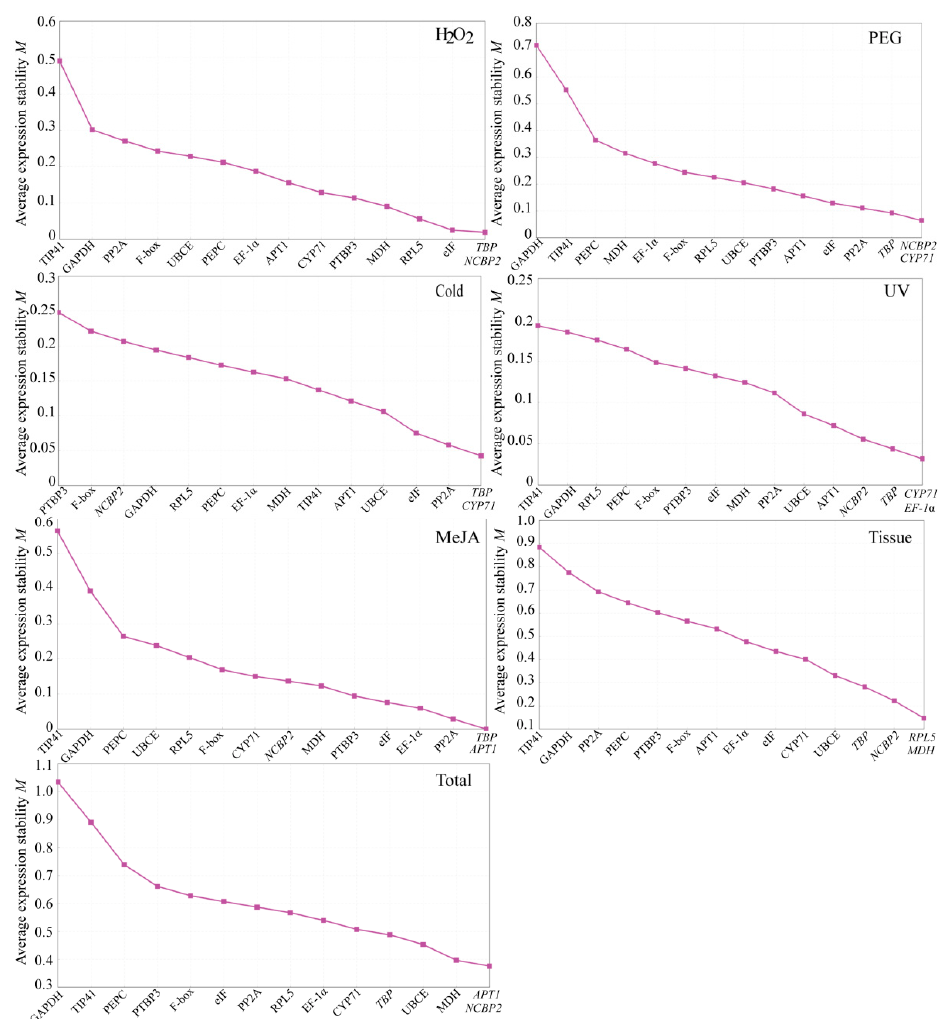
Figure 4. The rankings of the average expression stability values (M) of 15 reference genes using geNorm. Lower M values indicate more stable gene expression.